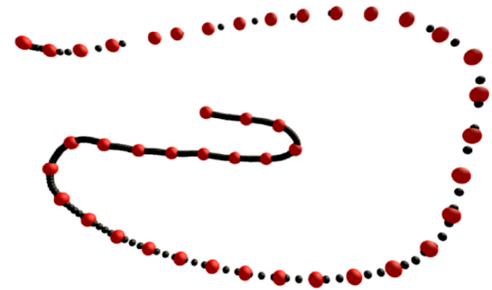
Figure 6. The diagram for the resampling.